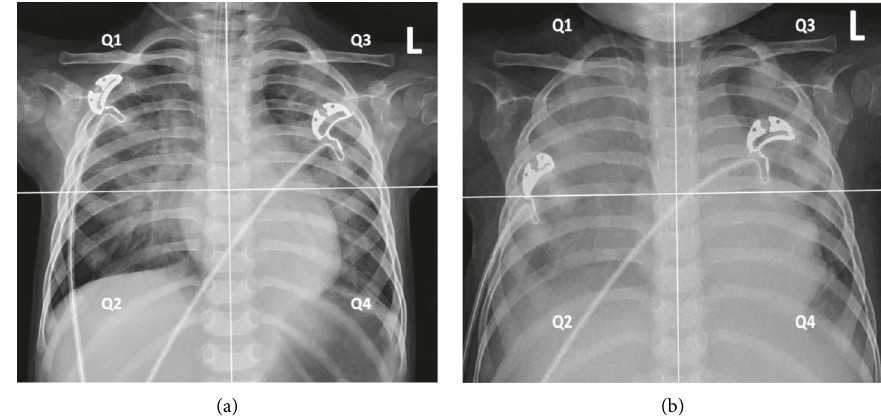
Figure 1: RALE scoring of a 19-month-old girl died of H1N1 pneumonia. (a). Day 1 (since intubation) RALE score was 16 points ( Q 1 � 2 × 2, Q 2 � 2 × 2, Q 3 � 2 × 2, Q 4 � 2 × 2). (b). Day 3 RALE score was 27 points ( Q 1 � 4 × 2, Q 2 � 4 × 2, Q 3 � 3 × 1, Q 4 � 4 × 2). ∗ Consolidation scores 0 (none alveolar opacity), 1 (extent < 25%), 2 (extent 25%–50%), 3 (50%–75%), and 4 ( > 75%). Density scores 1 (hazy), 2 (moderate), and 3 (dense).